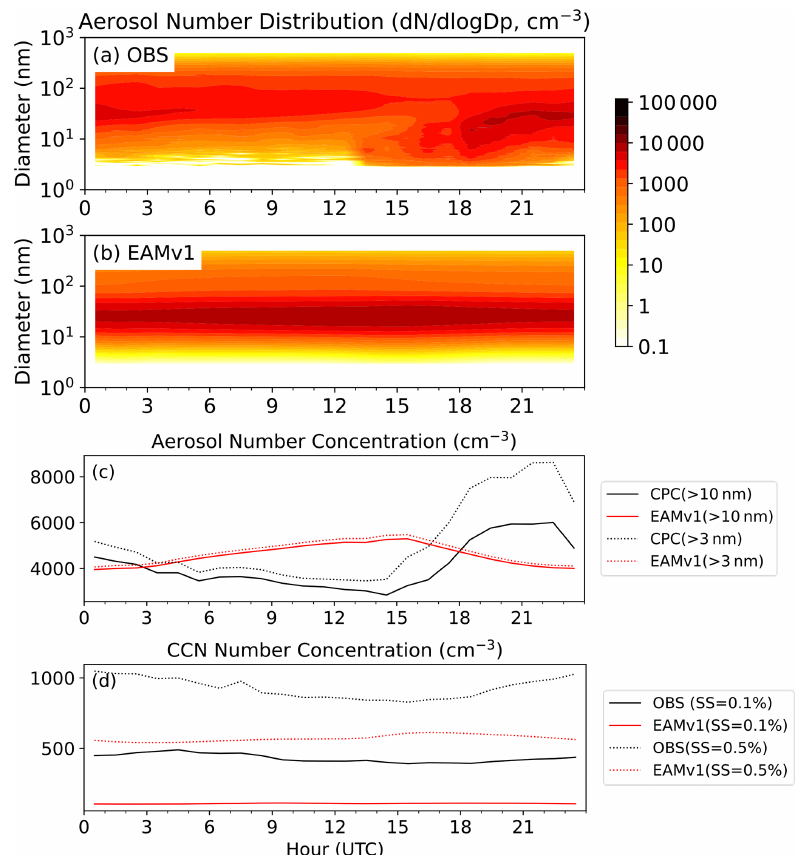
Figure 12. Average diurnal cycle of surface (a) observed aerosol number distribution, (b) simulated aerosol number distribution, (c) aerosol number concentration for diameters > 10 and > 3nm, and (d) CCN number concentration for supersaturations of 0.1% and 0.5% for HI- SCALE